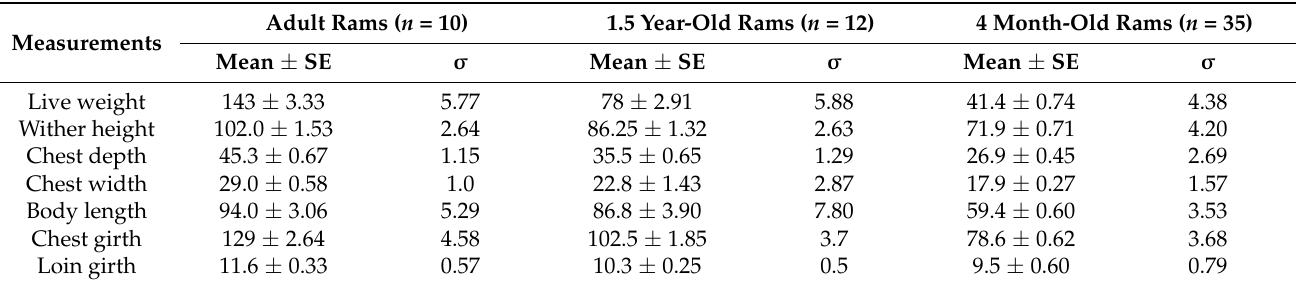
Table 2. Measurements and live weights of the Baisary breed at the experimental farm in the Kazakh Institute of Sheep Breeding, K.U.